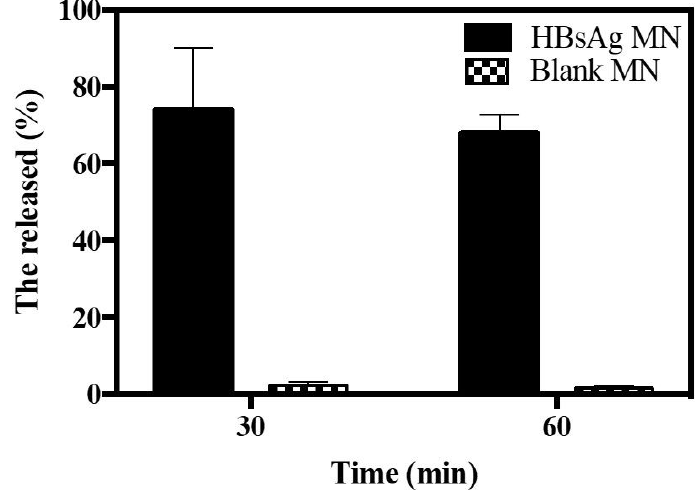
Figure 7. In vivo release profile of HBsAg MN after the application of HBsAg and blank MN ( n =